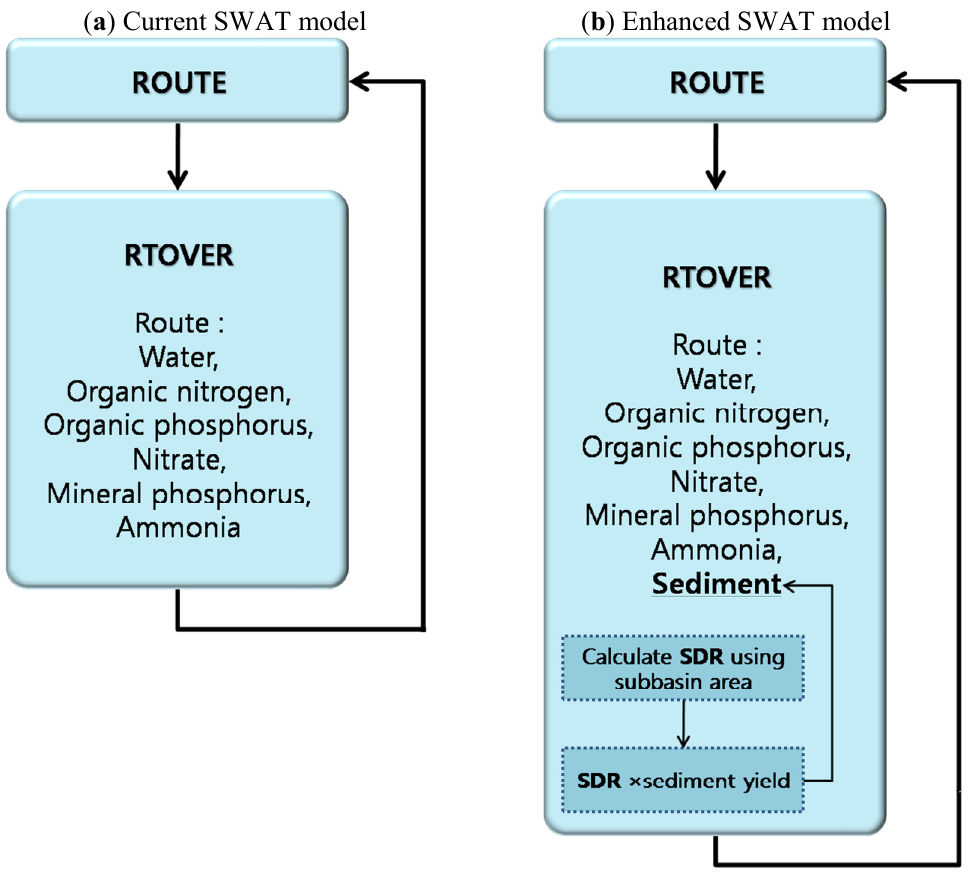
Figure 6. Enhancement of SWAT Sediment Routing under Overland Flow Type Enhancement of Filter Strip Module in the Current